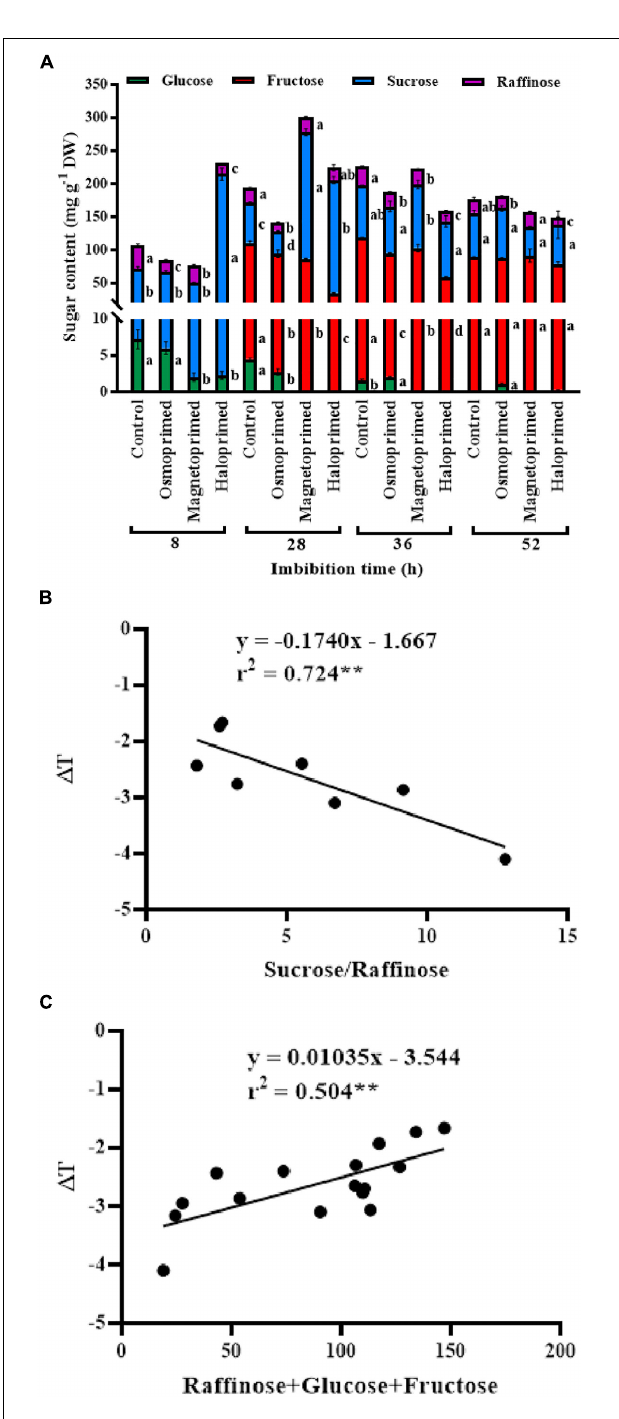
FIGURE 6 | (A) Sugar profile of differently primed onion seeds at different time of imbibition. Data represent mean ± SE of three biological replications. Different letters indicate significant differences among means of each treatment at particular time of imbibition based on LSD test ( p < 0.05). (B) Pearson’s correlation analysis between sucrose to raffinose ratio and relative temperatures ( (cid:49) T) of haloprimed and unprimed onion seeds. (C) Pearson’s correlation analysis between sum of raffinose, glucose, fructose, and relative temperatures ( (cid:49) T) of differently primed and unprimed onion seeds. Statistical significance: ** p < 0.01